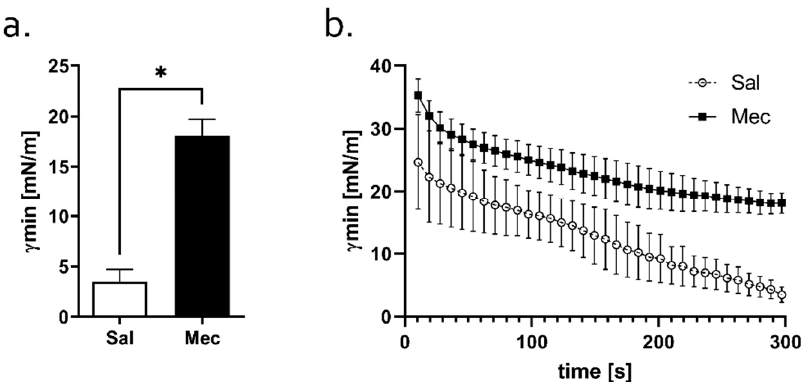
Figure 4. Surface activity of the surfactant obtained from BALF. ( a ) Minimum surface tension (ST; γ min) after 300 s of pulsation using the pulsation bubble surfactometer (PBS), ( b ) minimum ST of the pulmonary surfactants during the entire analyzed period for 300 s of cycling in PBS. Statistical comparisons for Mec vs. Sal * p < 0.05.